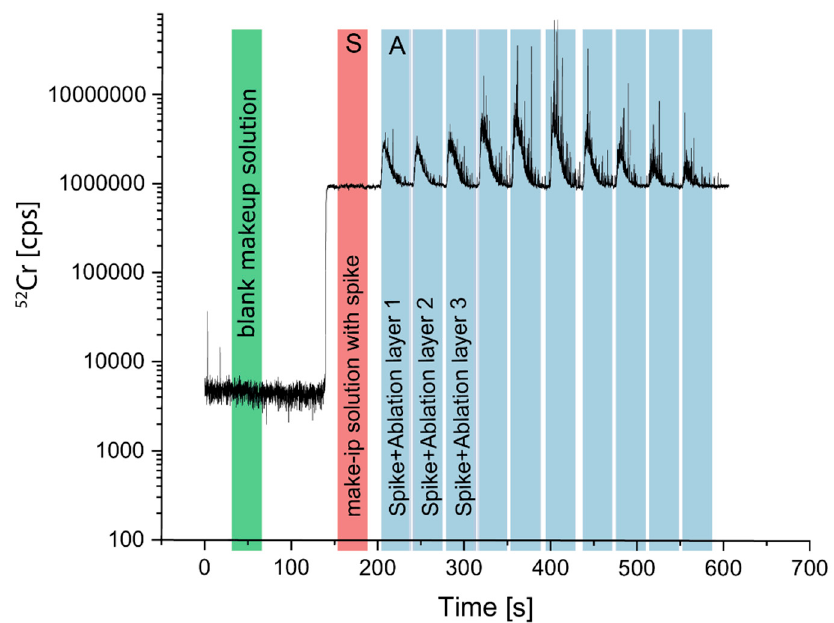
Figure 2. Illustration of the signal during a depth profile measurement with standard addition.